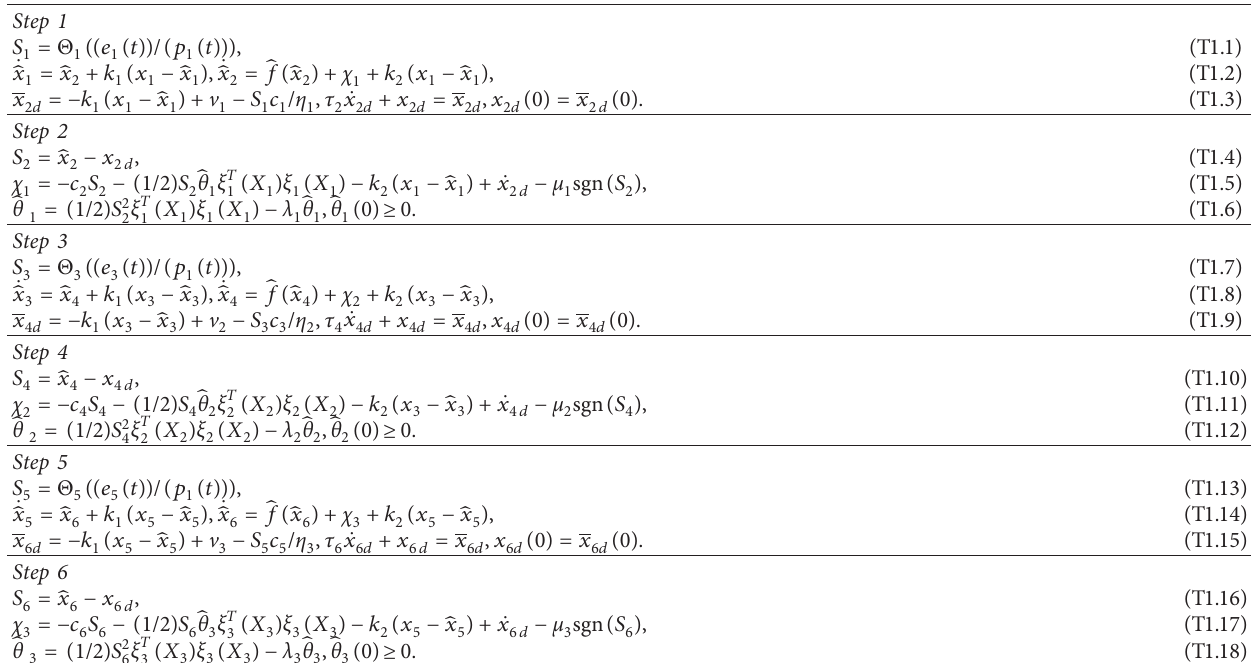
Figure 2: Structure of the proposed control Table 1: The proposed DSCSM design for position trajectory control.